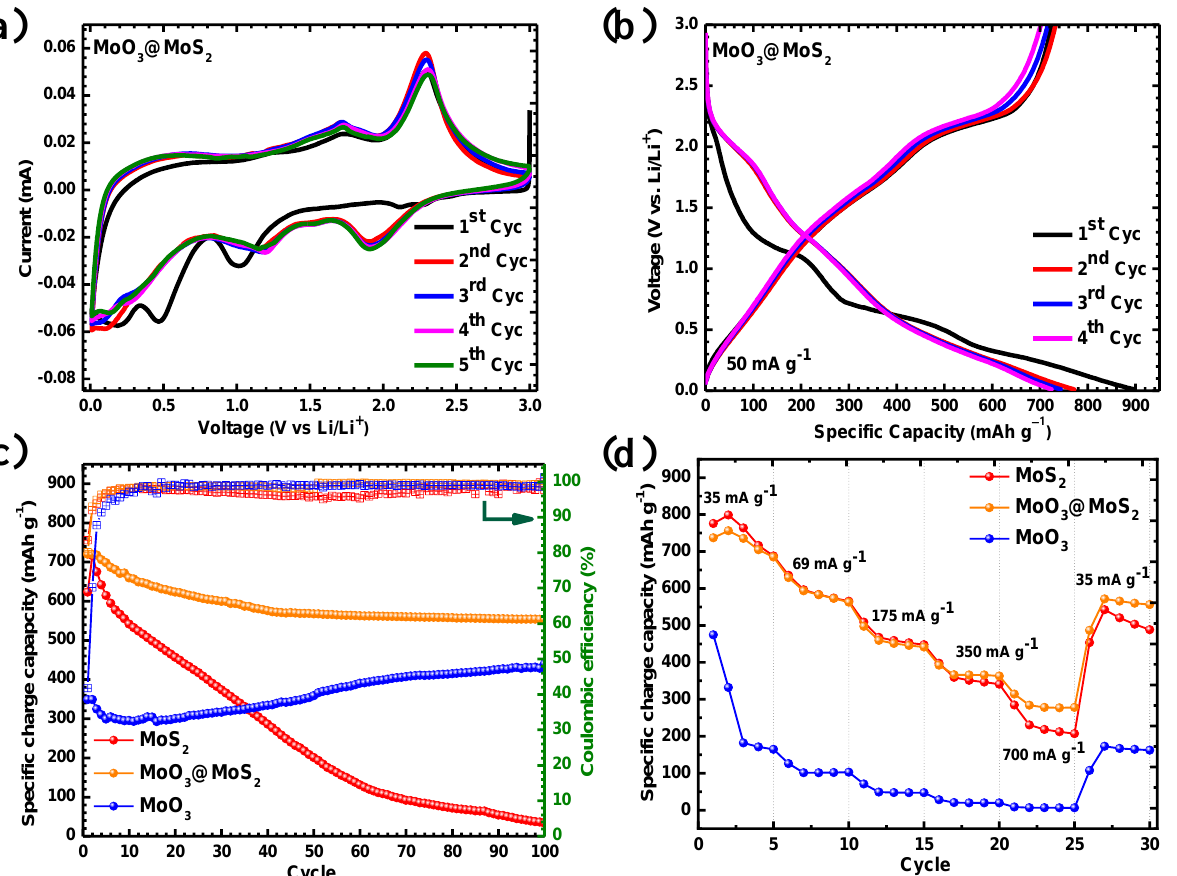
Figure 6. ( a ) CV and ( b ) discharge/charge profiles of MoO 3 @MoS 2 between (0.01 and 3.00) V. ( c ) Comparative cycling performance at a current density of 50 mA g – 1 and ( d ) rate performance of MoS 2 , MoO 3 @MoS 2 , and MoO 3 anodes in LIBs. Table 1. Electrical conductivity measurement (by four-point probe) results. Serial